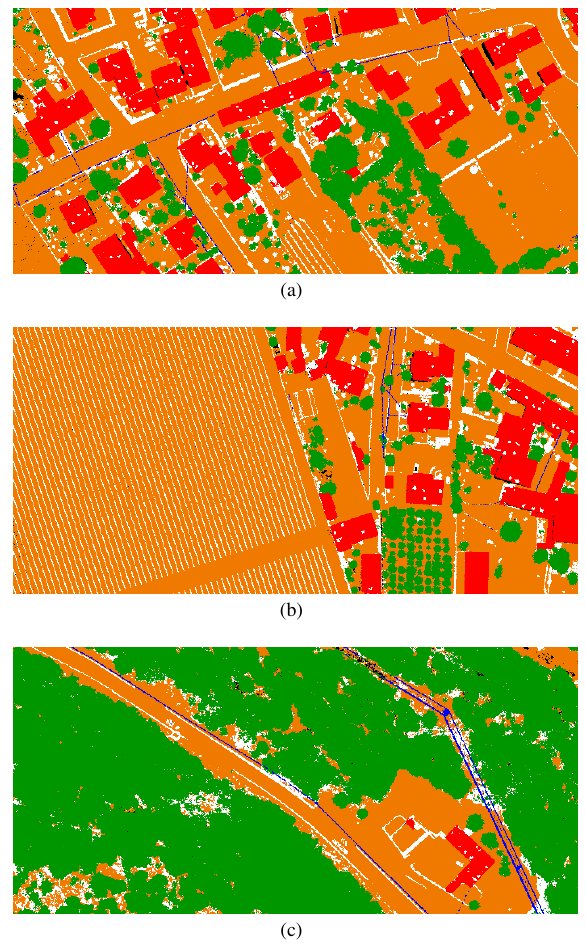
Figure 5. Examples of classification results (a) in an urban scenario, (b) in a rural area characterized by vineyards (on the left) and (c) in a mountainous environment (best viewed in color). Classes: ground (orange), vegetation (green), roof (red), overground - including low vegetation - (white), power line